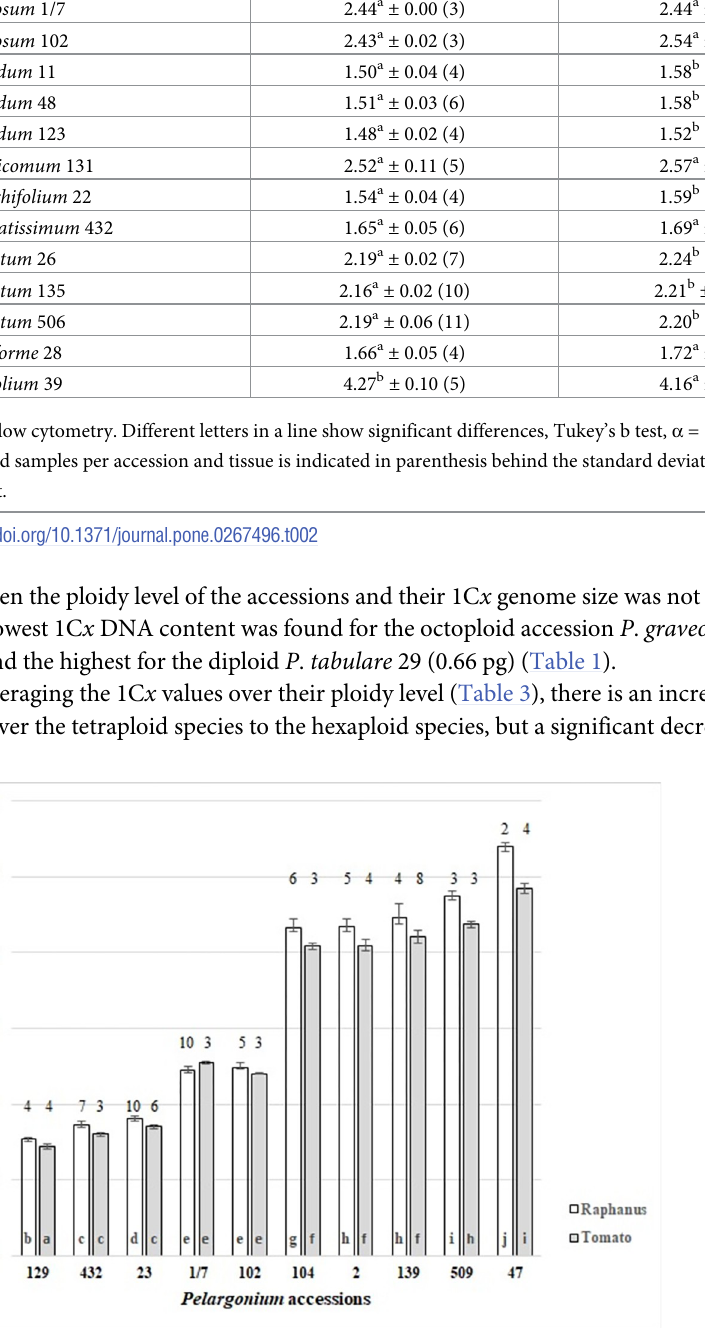
Fig 2. Comparison of flow cytometric 2C DNA content estimation of ten Pelargonium accessions using Raphanus sativus and tomato ‘Stupicke´’ as internal standard, different letters show significant differences, Tukey’s b test, α = 5%, numbers above the columns are numbers of the analyzed samples.